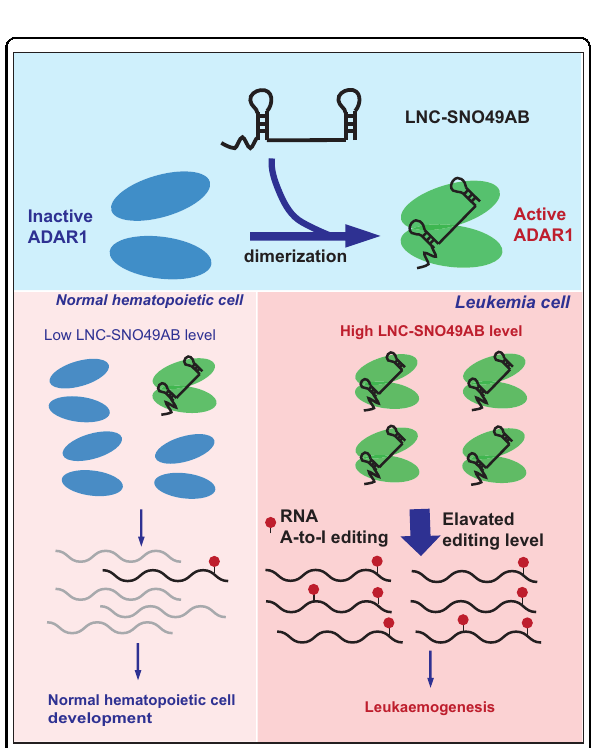
Fig. 7 Working model of the role and underlying mechanism of LNC-SNO49AB in leukaemogenesis. LNC-SNO49AB improves ADAR1 dimerization and its editing activity. Compared to normal hematopoietic cell, leukemia cell has a higher expression of LNC- SNO49AB, which can signi fi cantly enhance the activation of ADAR1- mediated RNA A-to-I